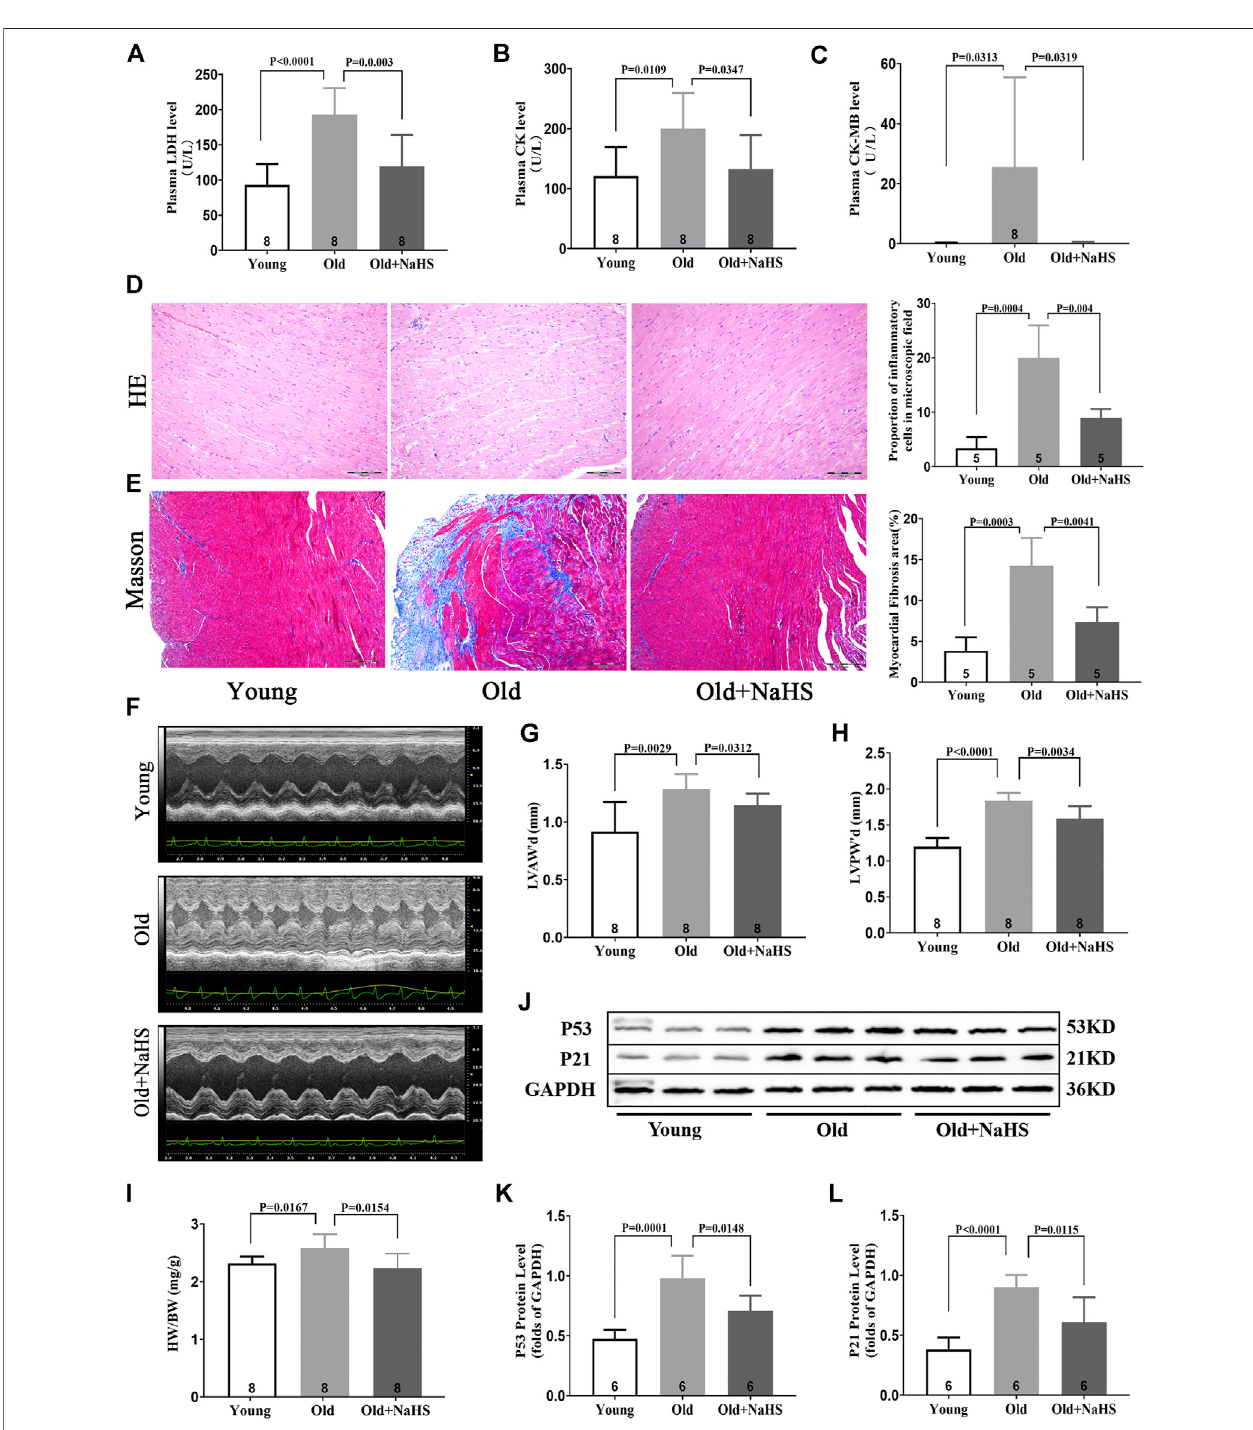
FIGURE5| H 2 Salleviatedmyocardialinjuryinagingrats. (A) LevelsofplasmaLDHinagingrats. (B) LevelsofplasmaCKinagingrats. (C) LevelsofplasmaCK-MB in aging rats. (D) Representative HE-stained myocardial sections in aging rats and quantitative data on in fl ammatory or death cells in microscopic fi eld (%). (E) Representative Masson-stained myocardial sections in aging rats and quantitative data on myocardial fi brosis (%). (F) Representative images of M-mode by echocardiography indicated LVAW and LVPW in agingrats. (G) Values of LVAW ’ d in aging rats. (H) Values ofLVPW ’ d in aging rats. (I) HW/BW ratios in agingrats. (J) Representative Western blots for P53 and P21 expressions in myocardial tissues of aging rats. GAPDH was used as the internal control. (K) Quantitative analysis for theP53expressioninthemyocardialtissueofagingrats. (L) QuantitativeanalysisfortheP21expressioninthemyocardialtissueofagingrats.Resultsaremeans±SEM. A p -value of < 0.05 was considered signi fi cant. LDH: lactate dehydrogenase. CK: creatine kinase. CK-MB: creatine kinase isoenzyme-MB. HW/BW: heart weight/body weight ratios.